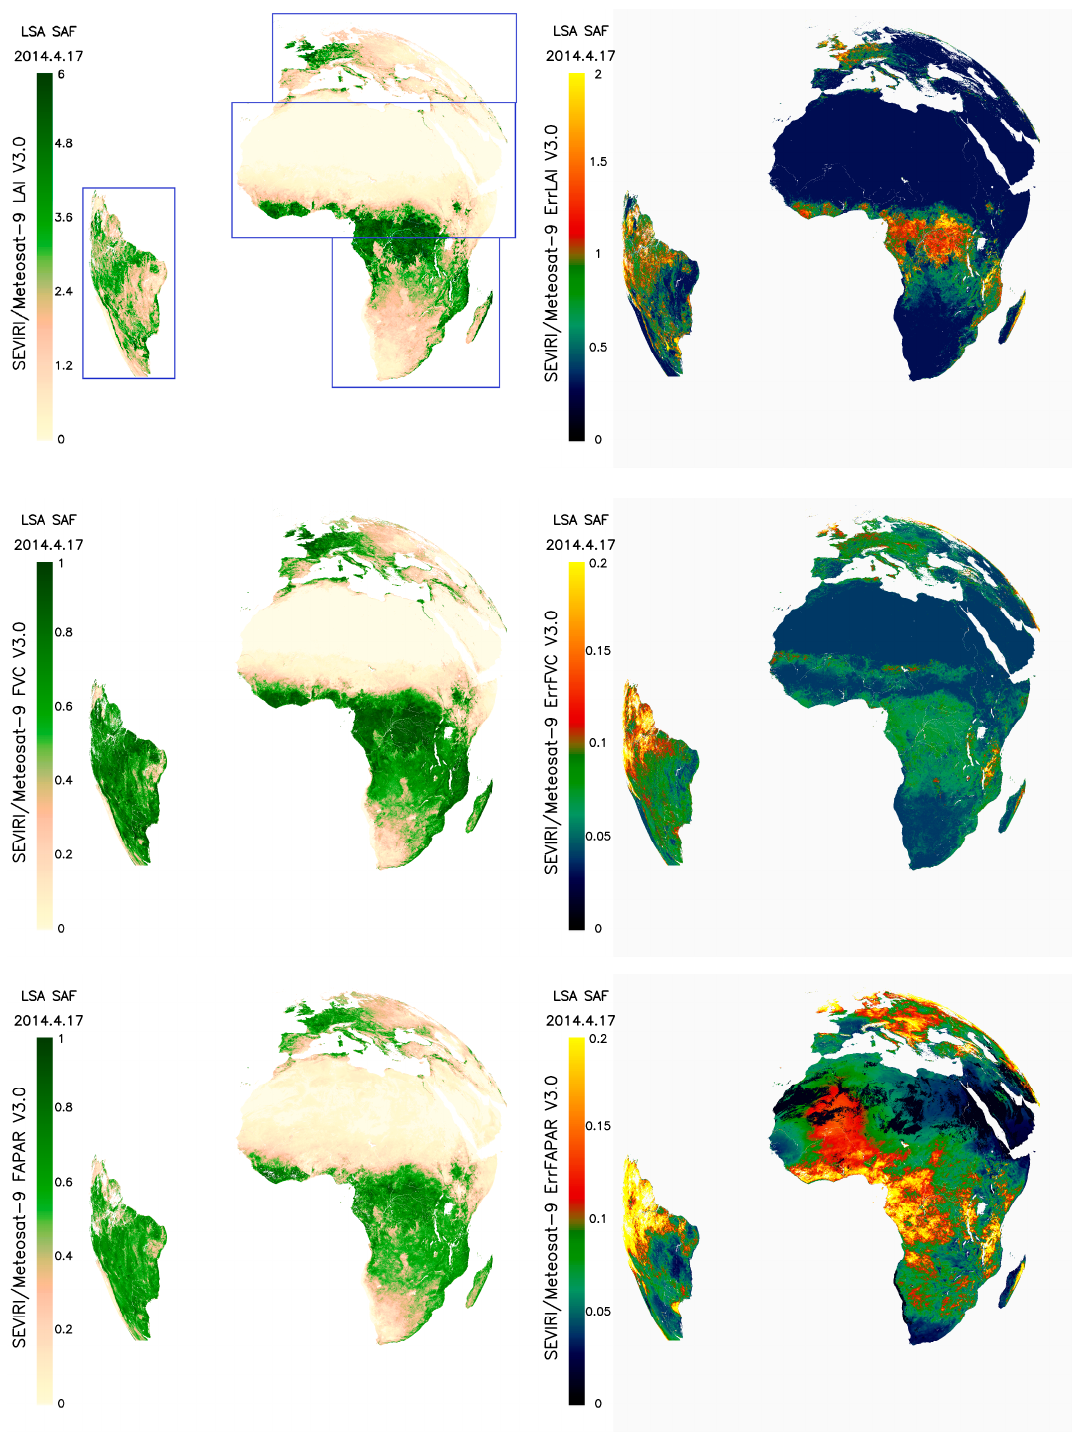
Figure 6. MSG Daily LAI (top), FVC (middle) and FAPAR (bottom) LSA SAF product composition corresponding to the 17th of April 2014 products (left panels) and their respective error estimates (right panels). Location of the four LSA SAF geographical areas is also provided. Rectangles in the LAI field are associated to Euro, NAfr, SAfr and Same SEVIRI geographical regions for illustrating purposes.